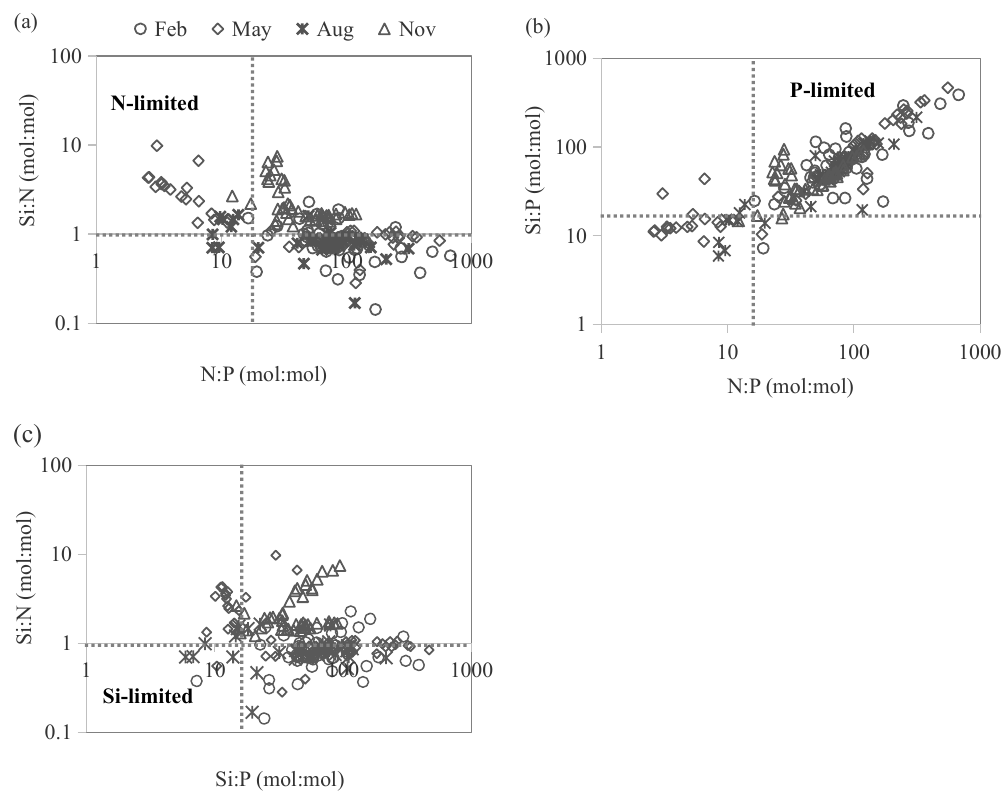
Figure 5. Scatter diagrams of atomic nutrient ratios in the Pearl River estuary (( a ) N-limited; ( b ) P-limited; ( c )